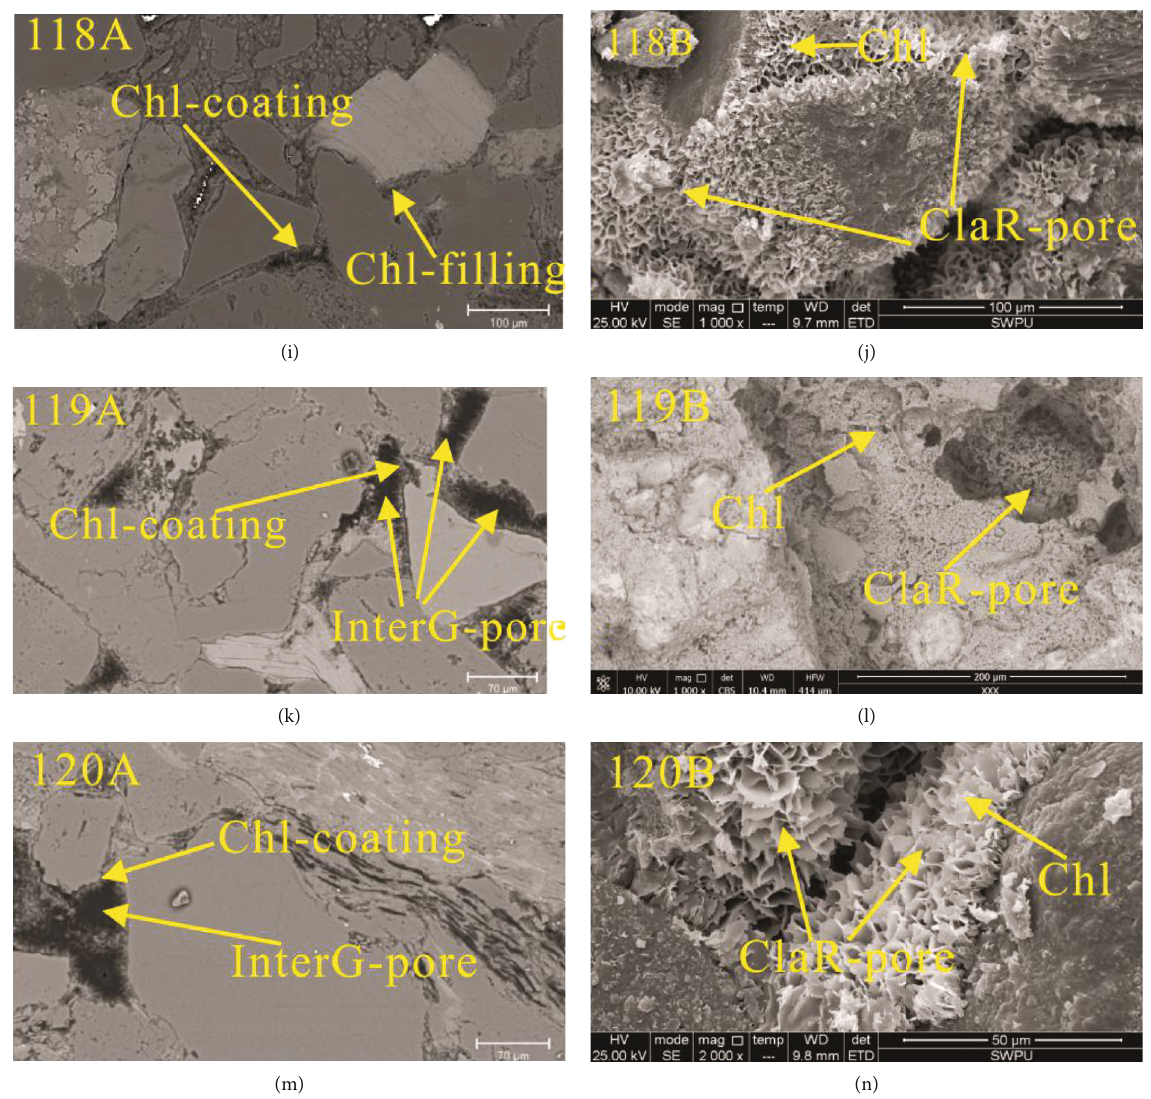
Figure 2: Typical clay and pore types identi fi ed by SEM images and backscatter images in tight sandstones. Chl: chlorite; Illi: illite; Kao: kaolinite; InterG: intergranular; Disso: dissolution; InterC: intercrystalline; ClaR: clay-related; micrF: